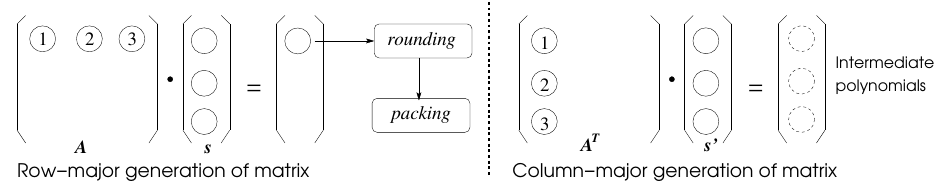
Figure 3: Matrix-vector multiplications during key generation and encryption. The numbers are used to indicate just-in-time generation of the polynomials of the matrices.